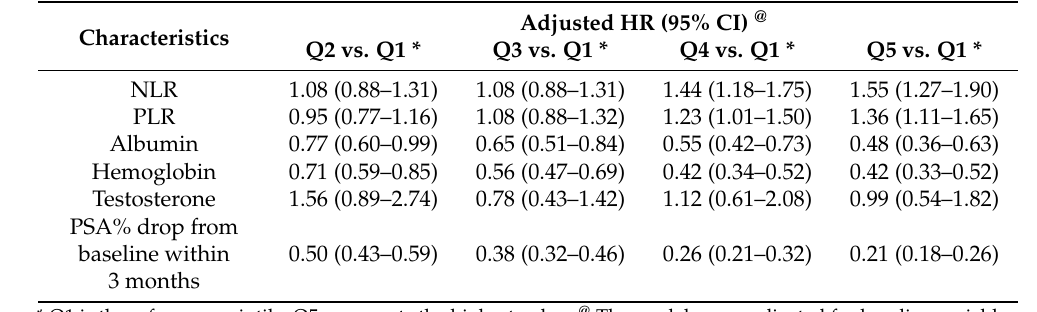
Table 3. Cox proportional hazards model of time to death by laboratory tests stratified by quin- tiles (Q).